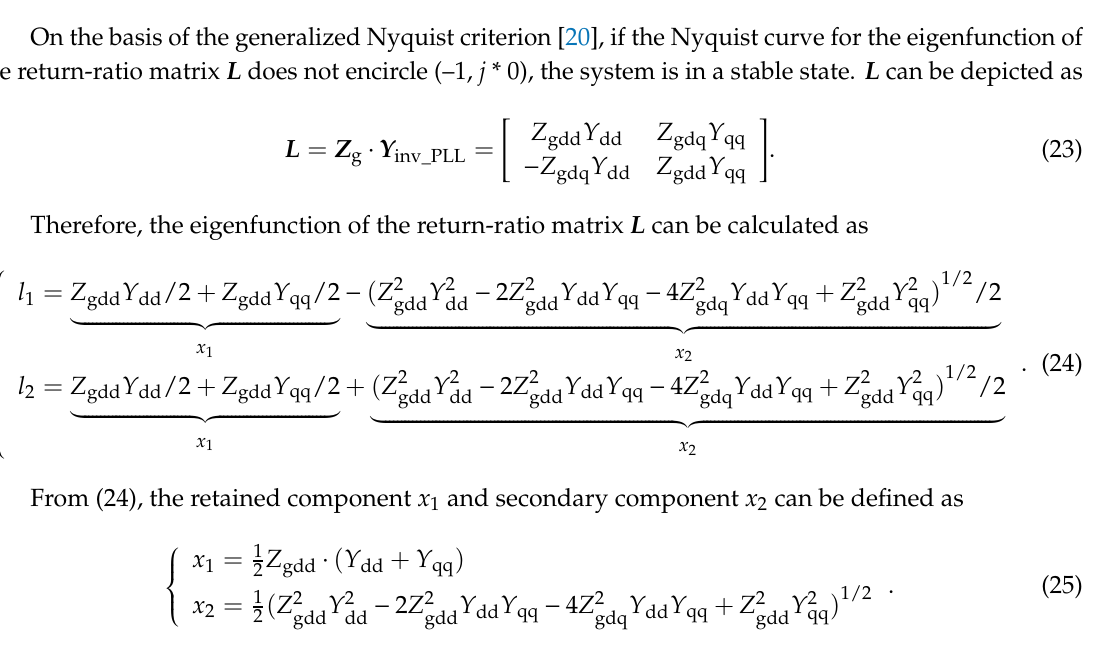
Figure 4. Equivalent circuit of the system with the traditional control method.